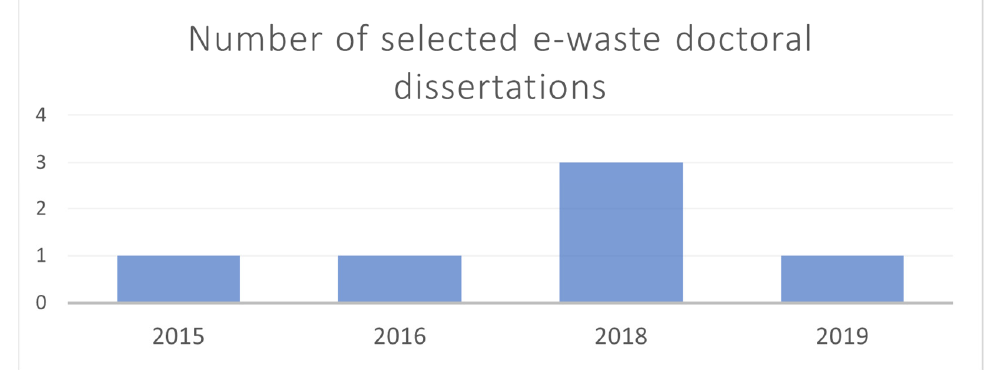
Figure 3. The number of selected for review e-waste doctoral dissertations published in recent years.